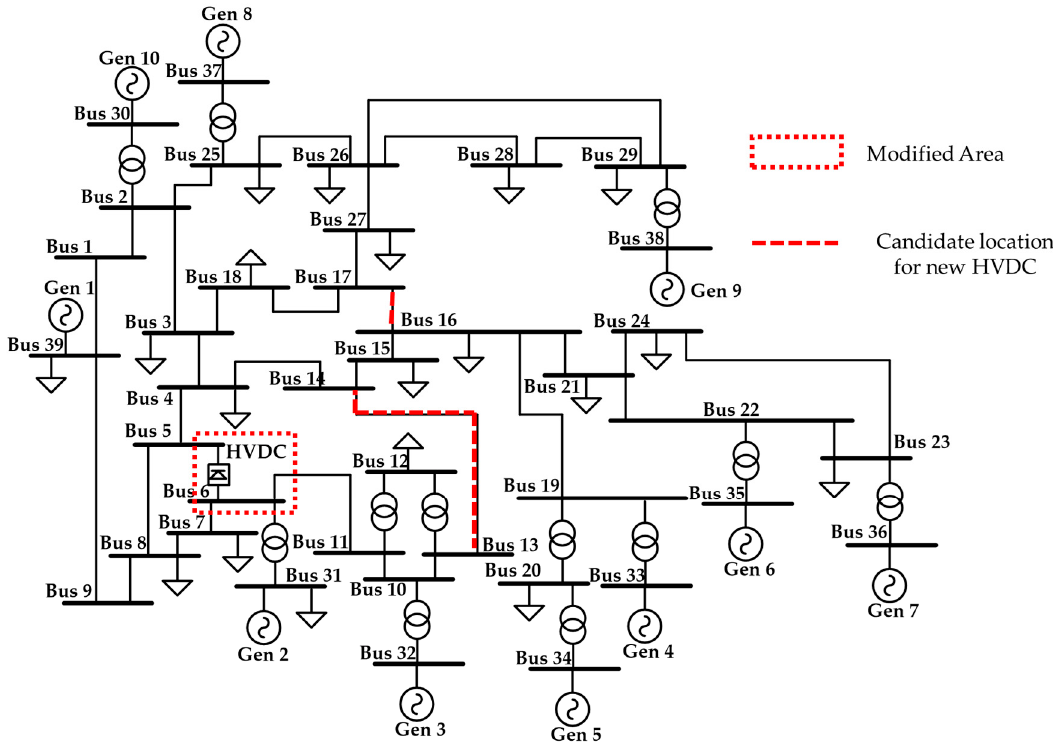
Figure 4. Modified IEEE 39-bus test system.